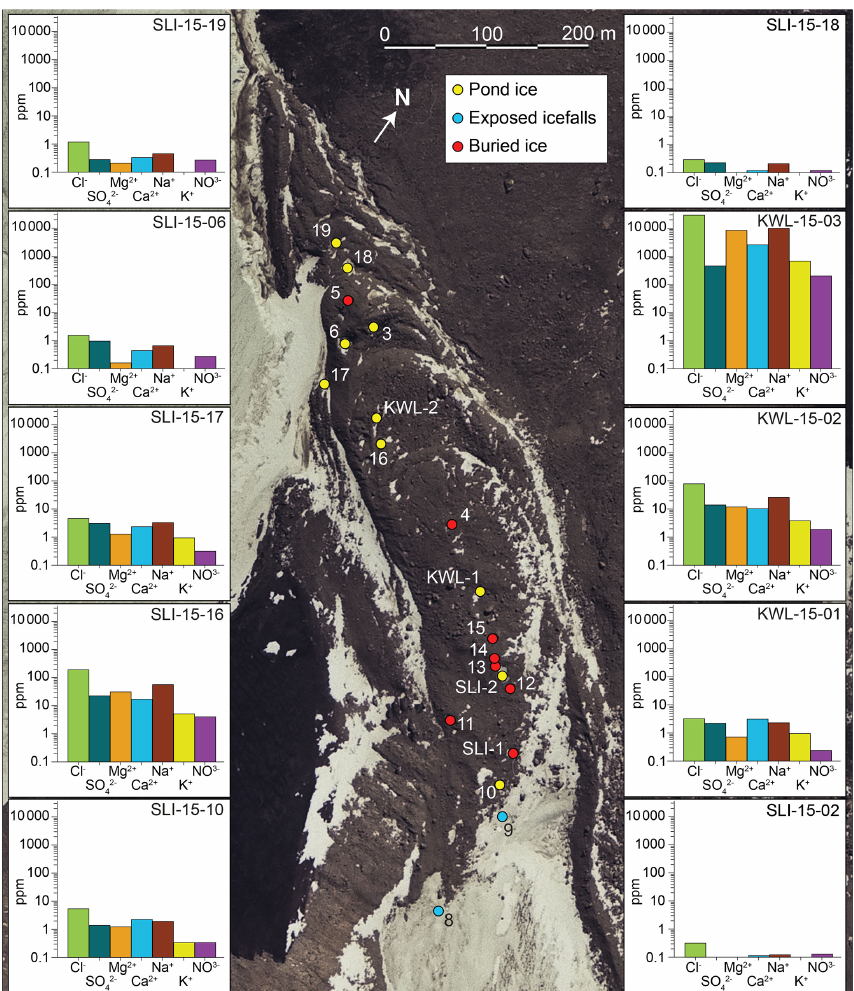
Figure 8. Aerial photo of the rock glacier with pond samples and buried ice samples. Cinder cone talus and the eastern margin of Sollas Glacier are both visible to the west of the rock glacier. Bar charts show major ion concentrations from 10 meltwater ponds (shown with yellow circles). All samples are labeled with their numbers only, except where the same sample numbers correspond to different samples (SLI-15-01 and SLI-15-02 vs. KWL-15-01 and KWL-15-02), labeled as SLI- and KWL-. Public domain aerial photograph from U.S. Geological Survey, TMA3084-V0132 taken in